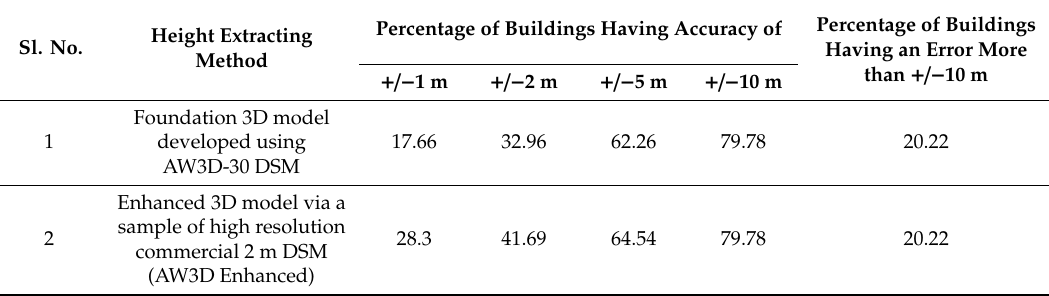
Table 6. Percentage of buildings under each level before (foundation 3D model) and after accuracy enhancement (enhanced model) for Huangpu District,